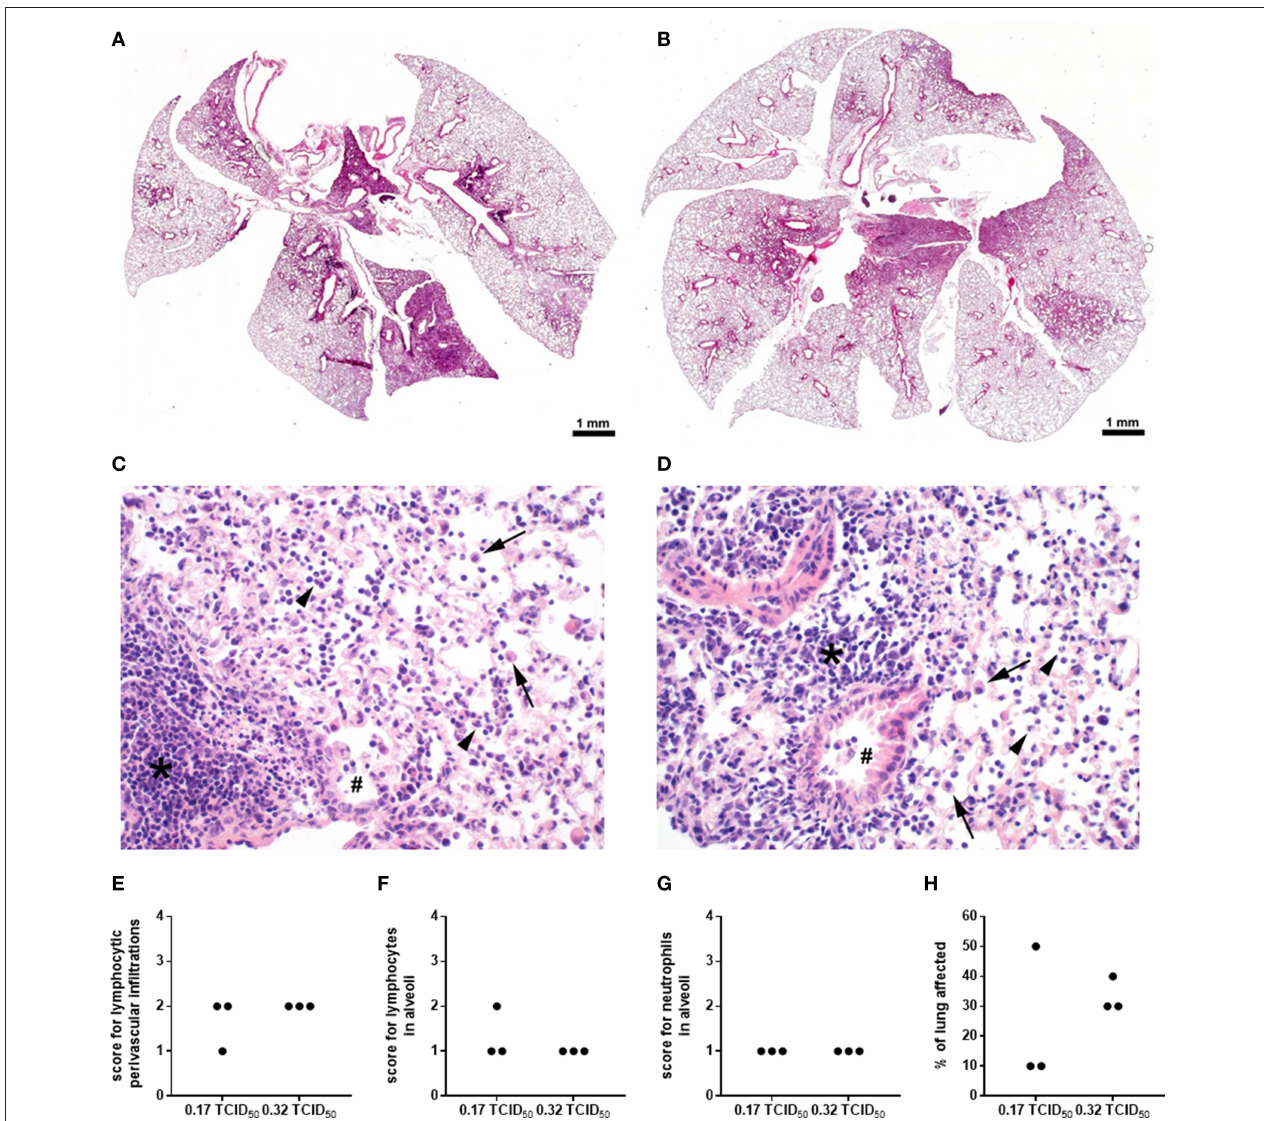
FIGURE 5 | Histopathological characterization of high and low dose IAV infection. WT C57BL/6J mice were intranasally infected with the A/PR8/34 H1N1 strain of IAV. Images show a representative overview (A,B) and details (C,D) ; 400x) of the histopathological changes observed in the lungs on day 7 post infection with 0.32 (A,C) or 0.17 (B,D) TCID 50 IAV following H&E staining. Bronchi (double crosses) contain few activated macrophages and the bronchiolar epithelium is attenuated and partially sloughed into the lumen. Alveoli are filled by sloughed epithelial cells, macrophages (arrows), degenerated neutrophils (arrow heads), and cellular debris. The alveolar septae and the perivascular and peribronchial interstitium are expanded by neutrophils, macrophages and lymphocytes (asterisks). Lymphocytic perivascular infiltrations (E) and the number of lymphocytes (F) and neutrophils (G) in the alveoli were scored on a scale from 1 to 4 and the percent of the lung affected by the infection (H) was evaluated and are shown for individual